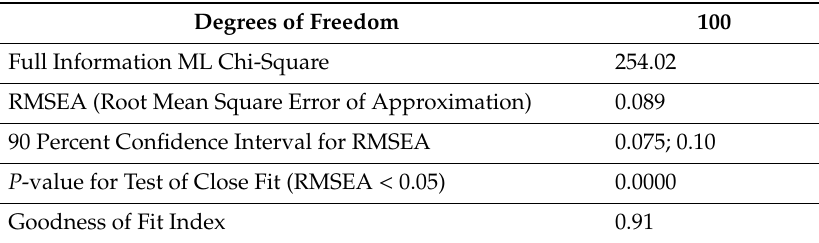
Table 4. Goodness-of-fit of the